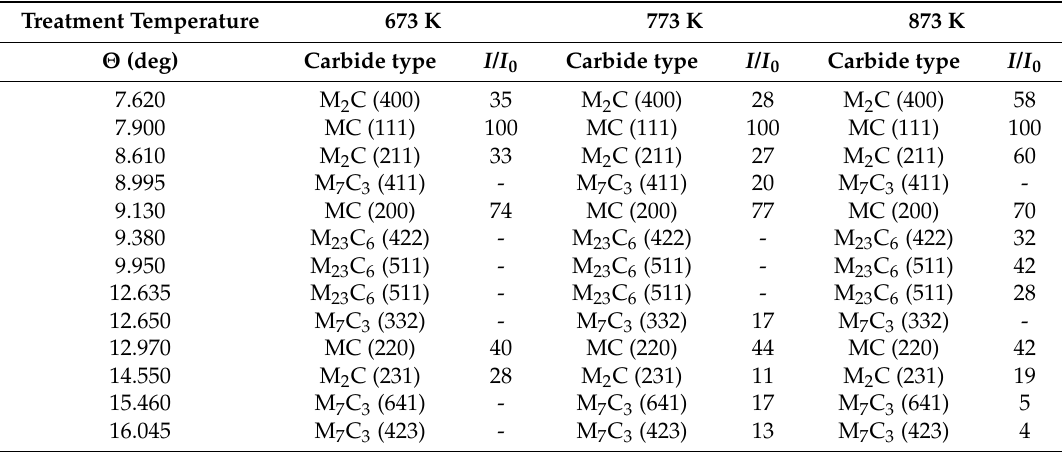
Table 7. Angular positions Θ and relative intensities I/I 0 of the XRD reflections of carbides extracted from samples heat treated up to 673, 773, and 873